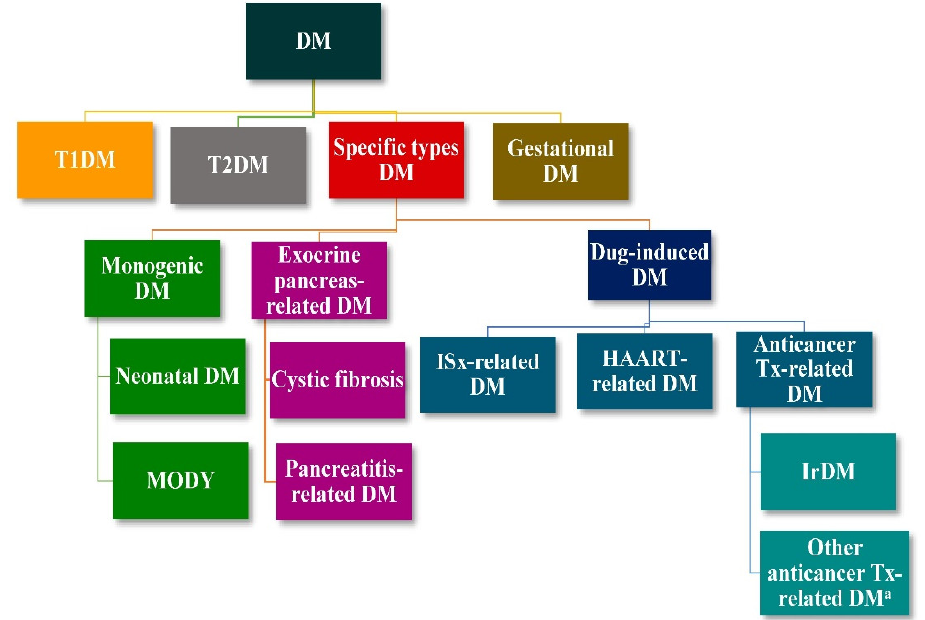
Figure 1. The classification of DM. a For other anticancer treatments known to cause DM, see Figure 4. Abbreviations: DM, diabetes mellitus; HAART, highly active antiretroviral therapy; irDM, im- mune-related DM; MODY; maturity onset diabetes of the young; T1DM type 1 diabetes mellitus, T2DM, type 2 diabetes mellitus; Tx, treatment.